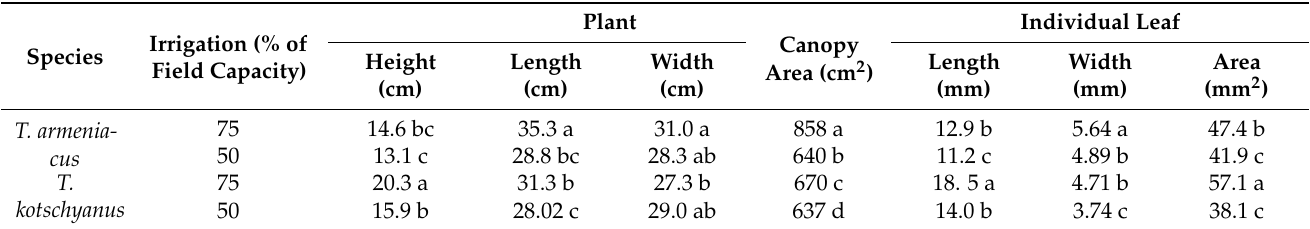
Table 2. Effect of irrigation regime on plant and individual leaf dimensions of two Thymus species. Assessments were conducted at 100% flowering. Within each column, different letters indicate significant differences ( n = 3).